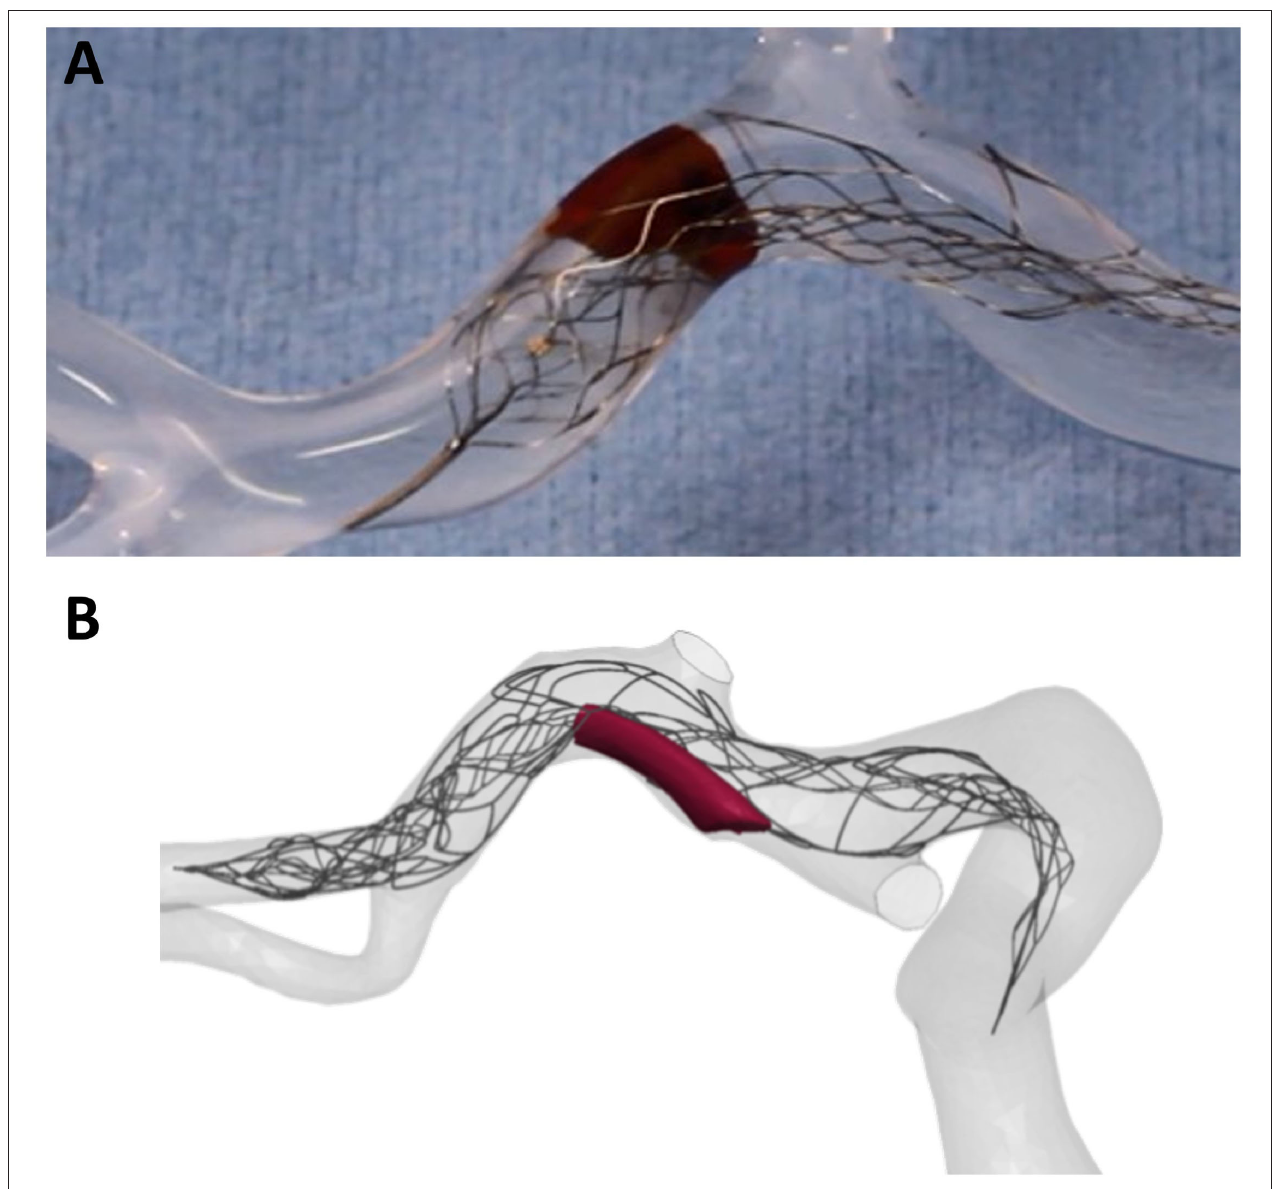
FIGURE 5 | Image of (A) in-vitro modelling of thrombectomy and (B) finite element in-silico simulation of thrombectomy. In-vitro models provide a great platform for this crucial validation step of in-silico models.